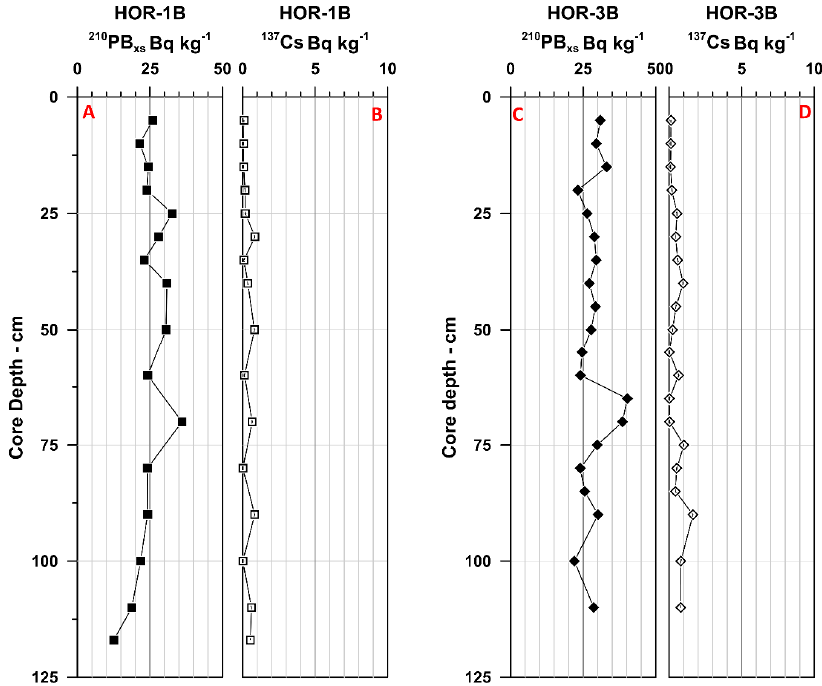
Figure 10. Constant flux-constant sedimentation (CFCS) model showing ( A ) excess 210 Pb and ( B ) total 137 Cs (Bq·kg − 1 ) for core HoR-1B, as well as ( C ) excess 210 Pb and ( D ) total 137 Cs (Bq·kg − 1 ) for core HoR-3B. See core location in Figure 1. The full results of the analysis are available in Table S6 (Supplementary Materials).